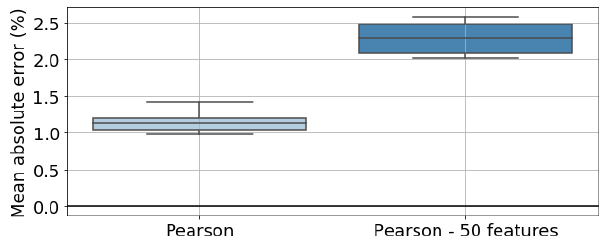
Figure 8. Comparison of mean absolute error between model trained with features selected by Pearson’s r and just the first 50 fea- tures